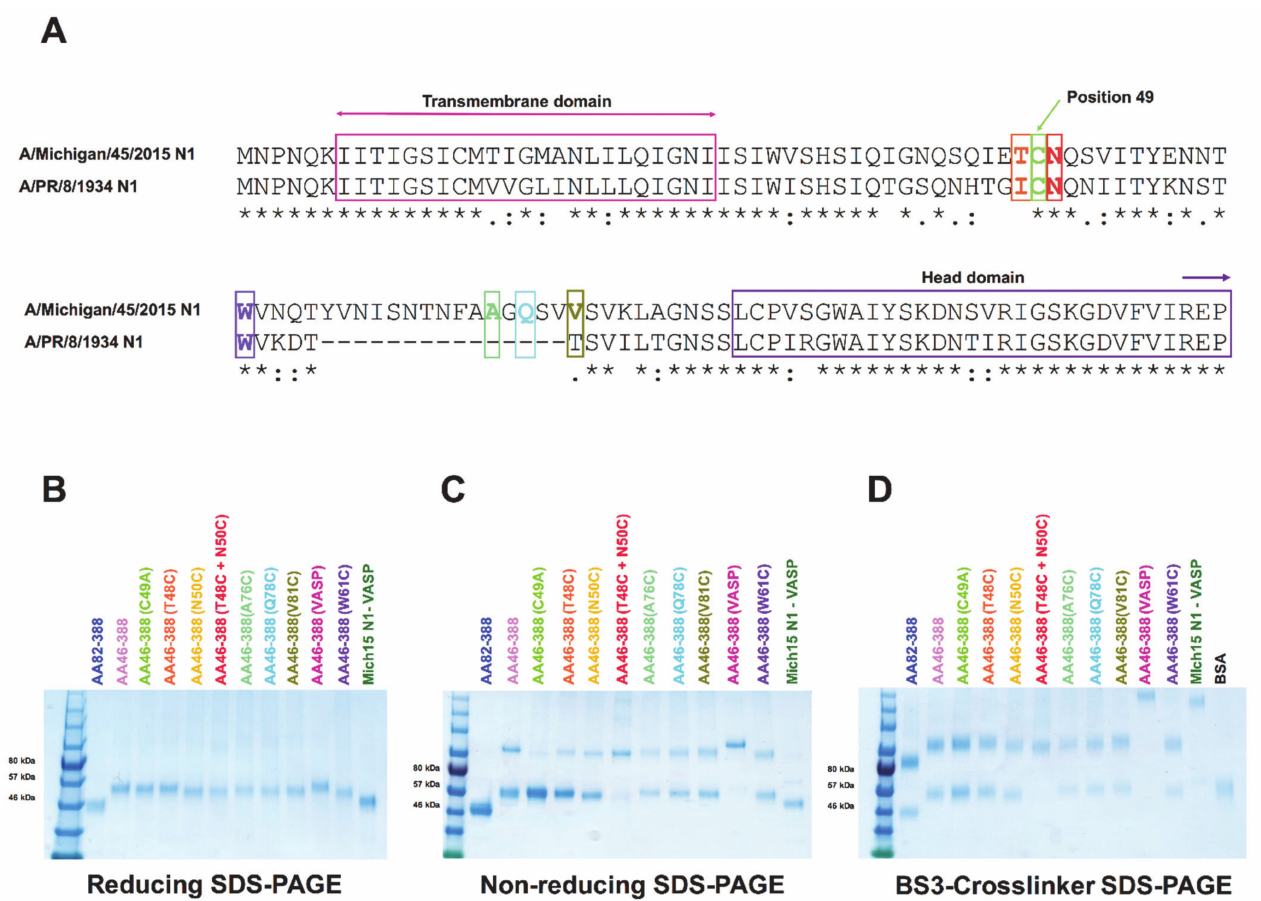
Figure 1. Sequence and structural analyses of recombinant NA constructs. A sequence alignment between the stalk domain of A/Michigan/45/2015 N1 and A/PR/8/1934 N1 is shown (* indicates identical amino acids, : indicates similar amino acids, . indicated by the dotted line). The recent A/Michigan/45/2015 strain contains a 15aa longer NA stalk domain compared to the older A/PR/8/34 isolate. The transmembrane domain and the start of the globular head domain are highlighted with arrows. Sites chosen for the introduction of an additional cysteine mutation are shown in different colors ( A ). NA constructs were analyzed by reducing SDS-PAGE under denaturing conditions to identify monomers ( B ); by non-reducing SDS-PAGE to show dimers ( C ); or treated with a BS3 crosslinker ( D ) to evaluate the formation of